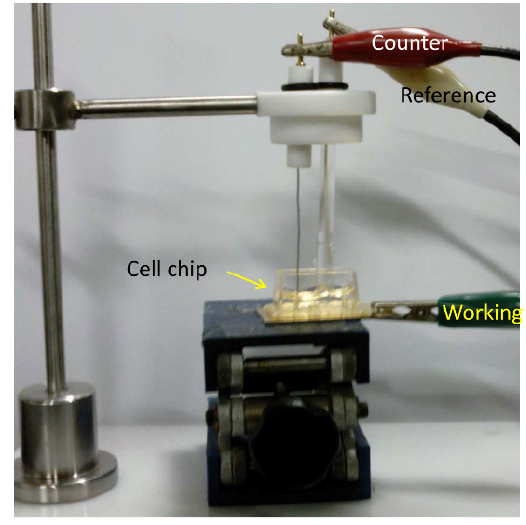
Figure 4. The fabricated chip with thee electrode setup for electrochemical measurement of cell cycle progression. Adapted with permission from [15], Copyright 2011, American Chemical